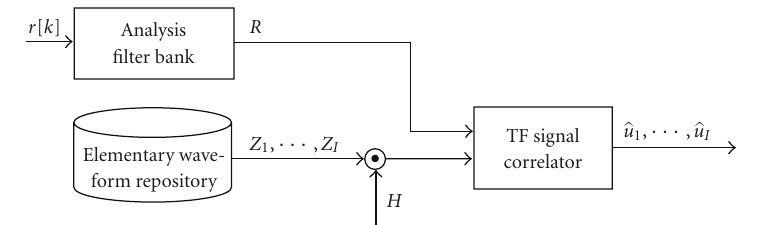
Figure 5: Generic TF domain matched